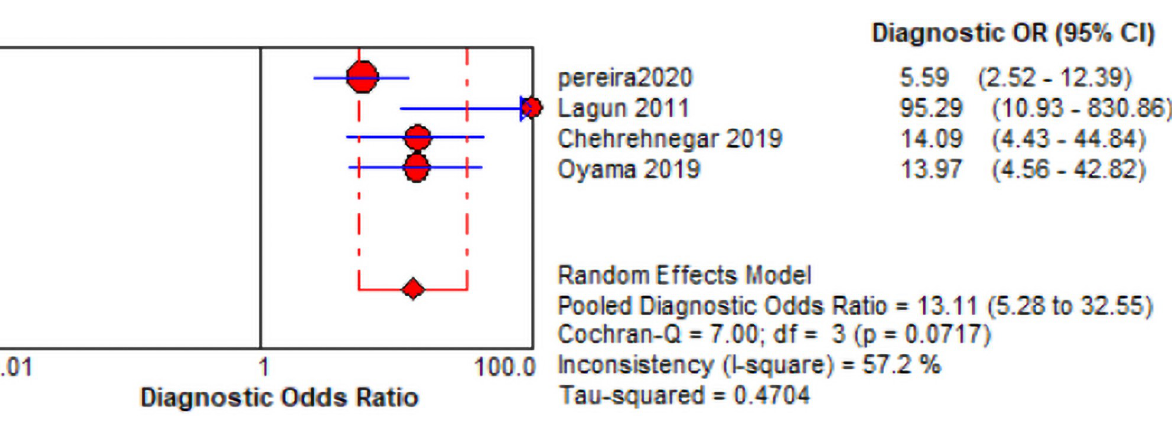
Fig 12. After subgroup analysis—Forest plot of the